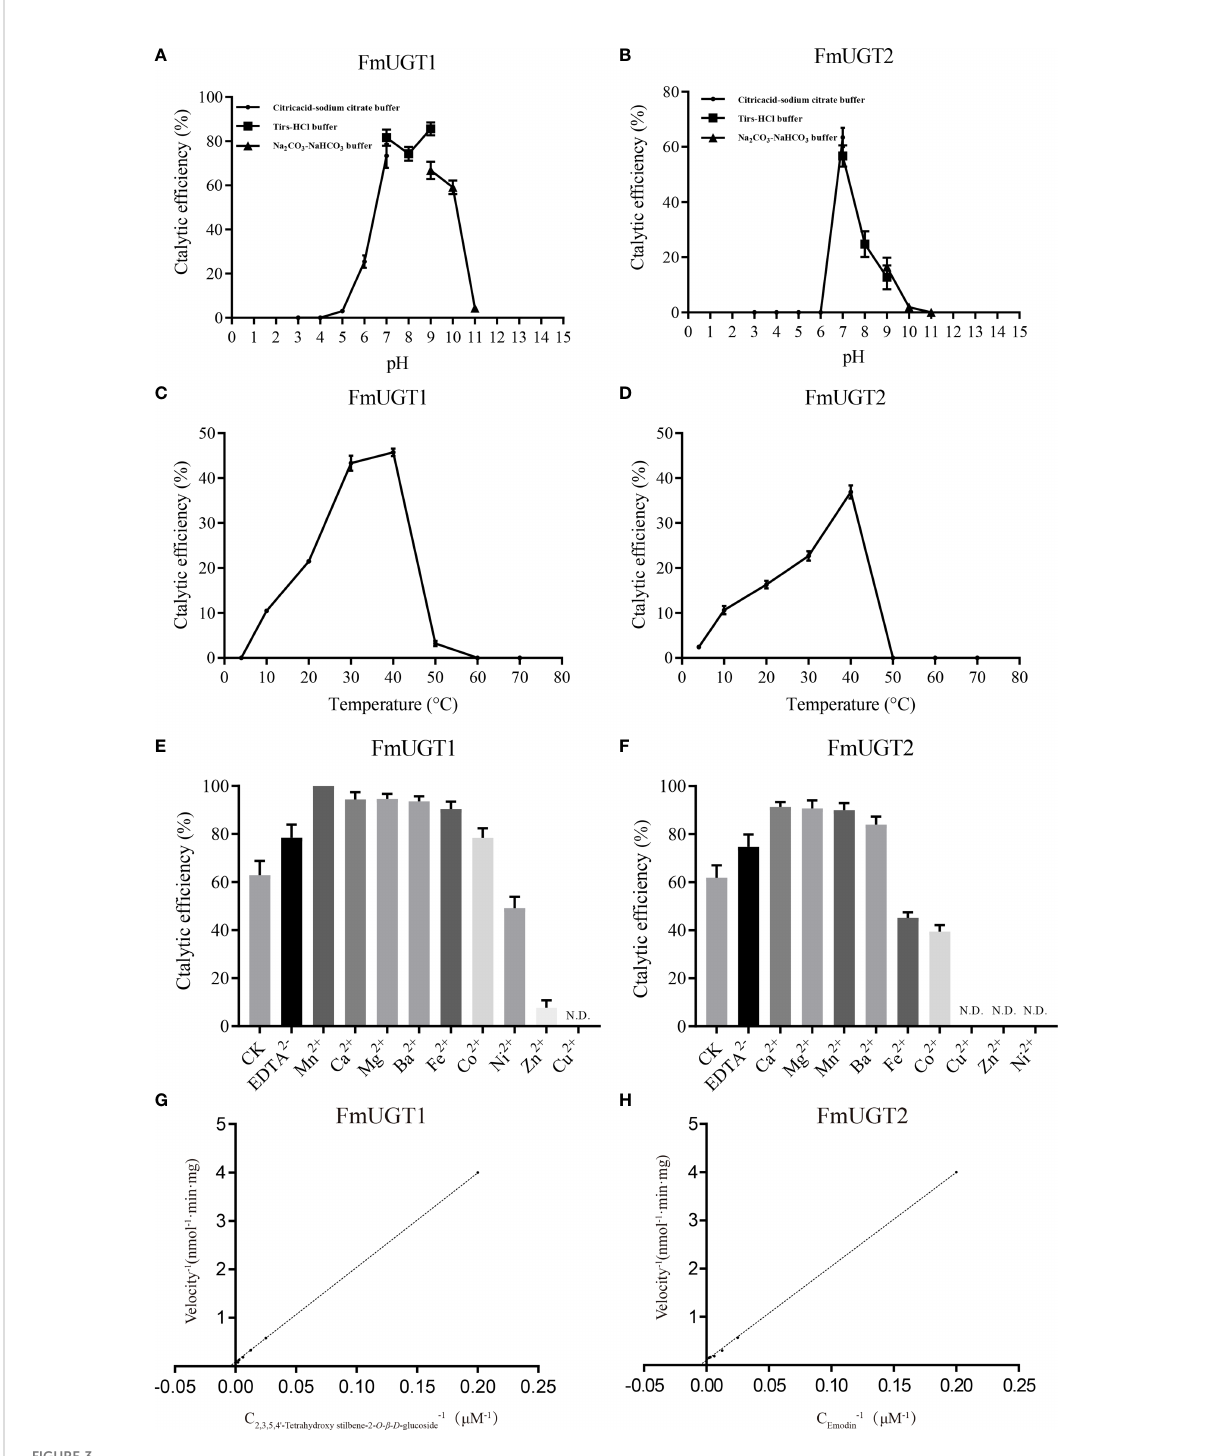
FIGURE 3 Biochemical properties of recombinant protein FmUGT1 and FmUGT2. (A) Effect of pH on the enzyme activity of FmUGT1. (B) Effect of pH on the enzyme activity of FmUGT2. The points represent Citric acid-sodium citrate Buffer (pH3.0-7.0), the squares represent Tris-HCl buffer (pH7.0-9.0), the triangle represent Na 2 CO 3 -NaHCO 3 buffer (pH9.0-11.0). (C) Effect of temperature on the enzyme activity of FmUGT1. (D) Effect of temperature on the enzyme activity of FmUGT2. (E) Effect of metal cations on the enzyme activity of FmUGT1. (F) Effect of metal cations on the enzyme activity of FmUGT2. (G) The Lineweaver-Burk plot of FmUGT1. (H) The Lineweaver-Burk plot of FmUGT2. Values of the relative activities are mean ± SD